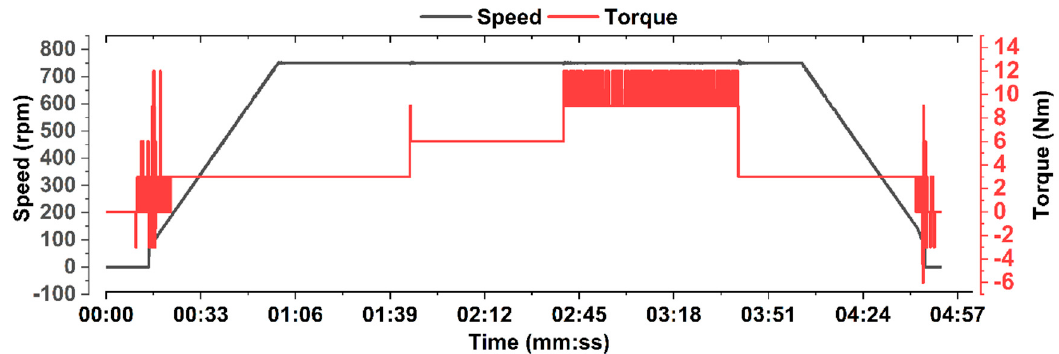
Figure 12. Experimental results for loading up to the rated torque: Speed and torque response of the motor controlled by AC motor drives.